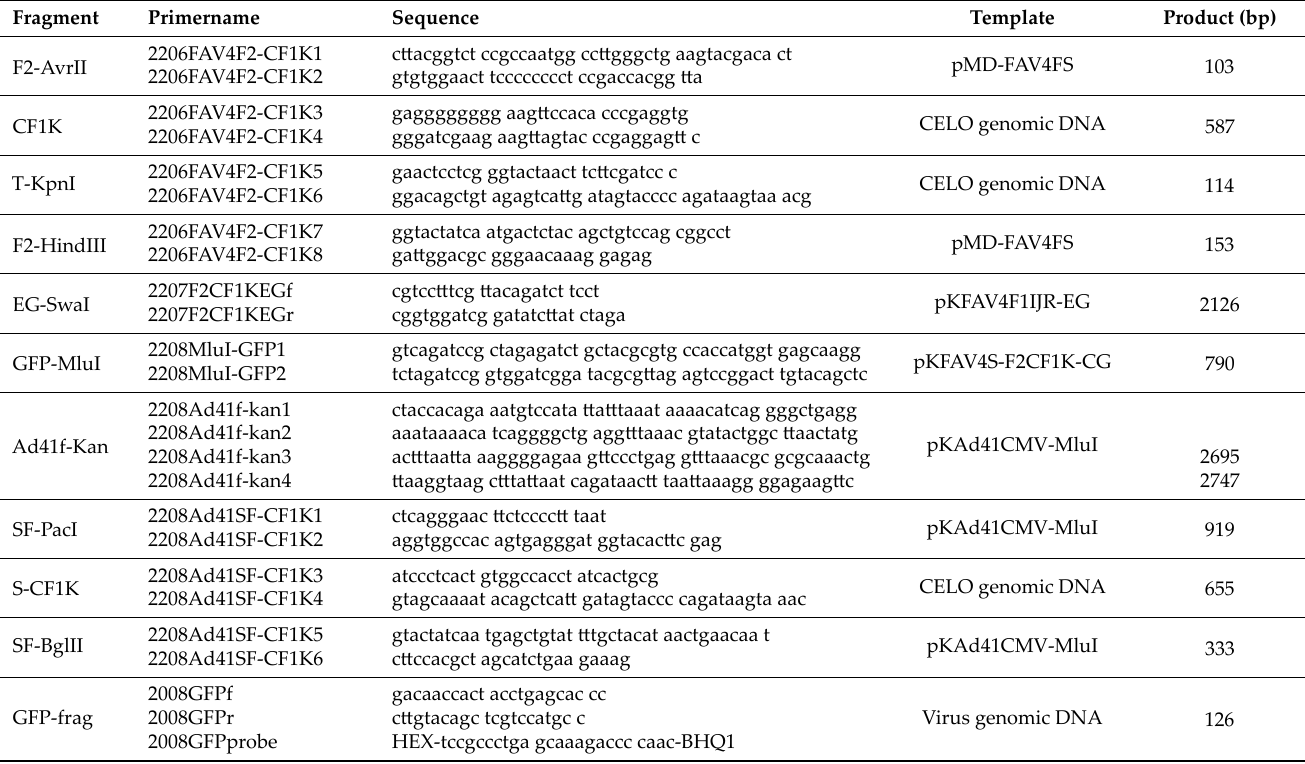
Table 1. Summary information of PCR